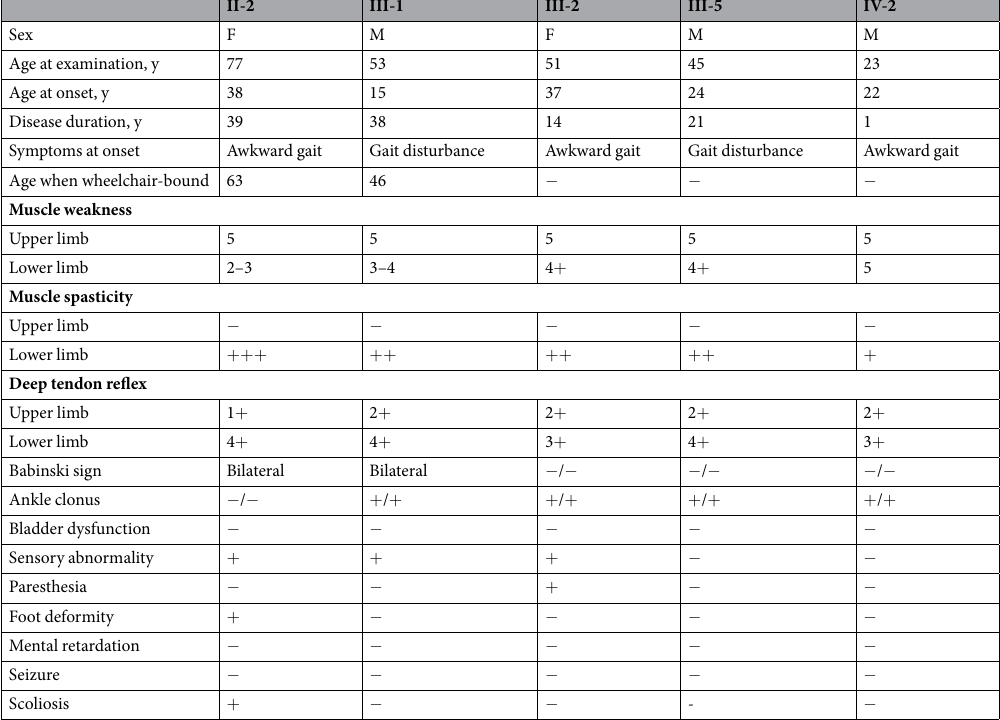
Table 1. Clinical features of patients with the ERLIN2 mutation. − , absent; + , mild; ++ , moderate; +++ , severe.